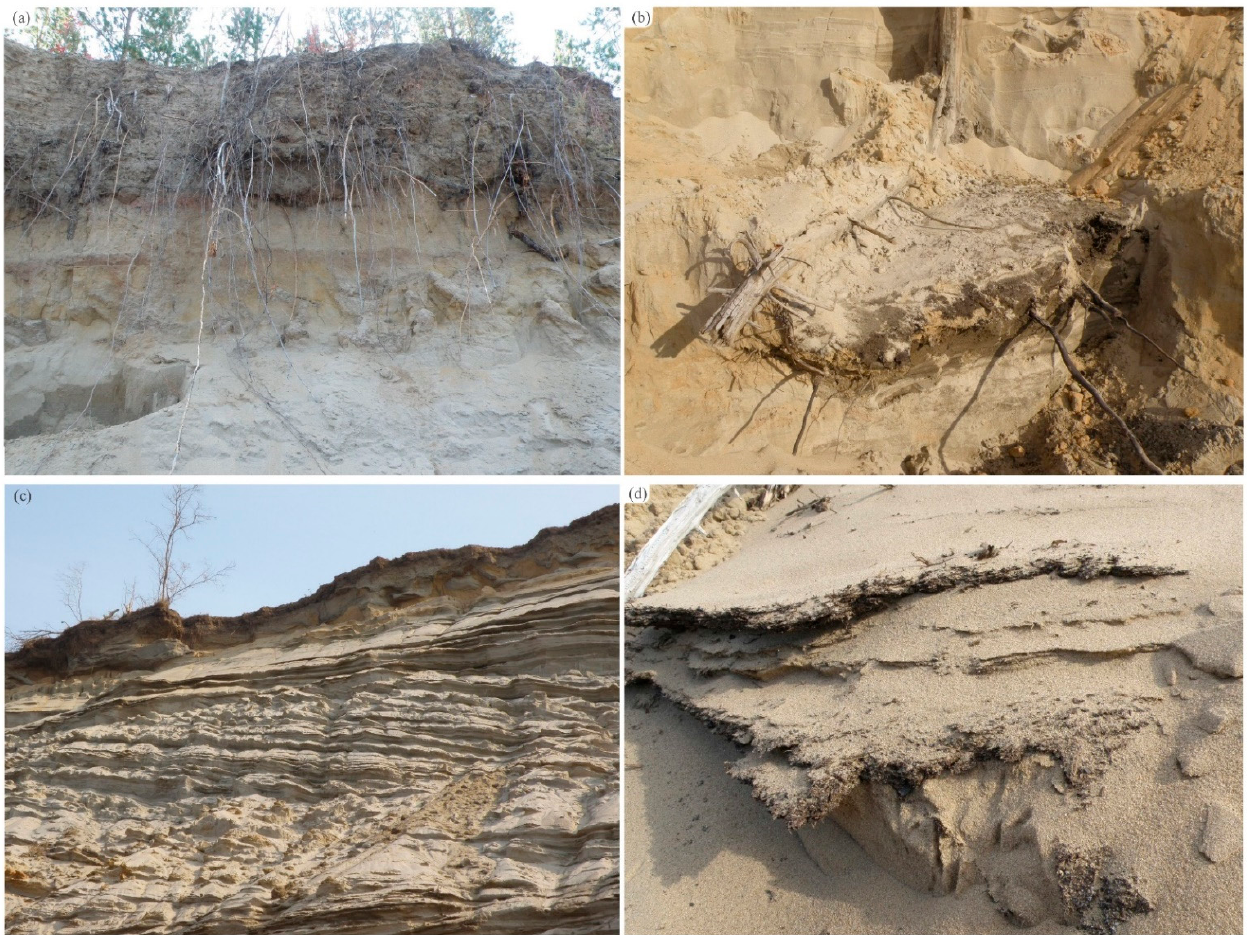
Figure 9. Subaerial deposit: ( a ) modern soil, Central Yakutia, ( b ) late Pleistocene paleosol, Kharyyalakh, Central Yakutia, ( c ) aeolian deposit with a layer of plant debris and insect fragments, ( d ) recent aeolian deposit with plant debris and insects, Ust-Buotama dune, Central Yakutia.